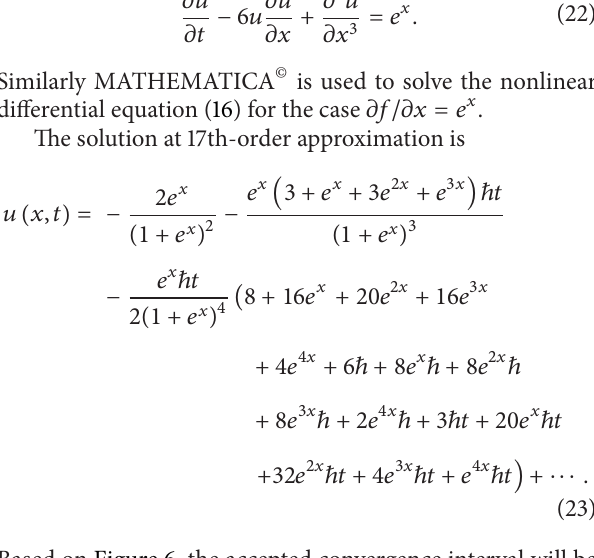
Based on Figure 6, the accepted convergence interval will be −1.7 ≤ ℎ ≤ −0.5 . For further deliberation, the convergence values of ℎ are chosen as, ℎ = −0.5 , ℎ = −1 , and ℎ = −1.7 . The outcomes for the 𝑒 𝑥 force term are shown in Figure